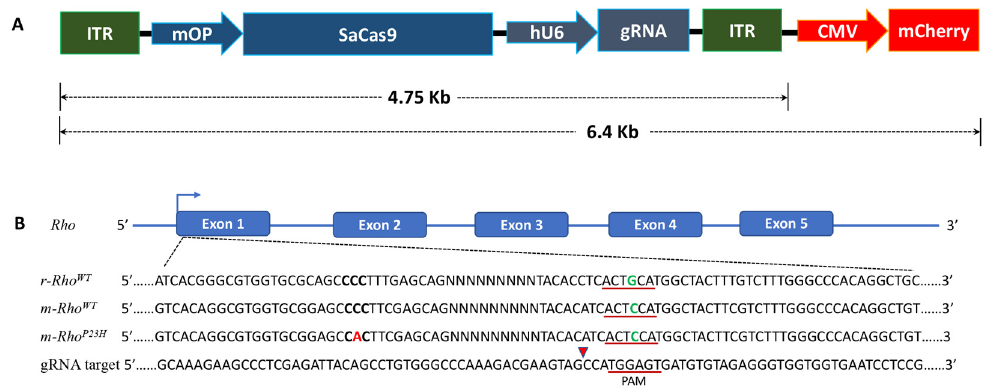
Figure 1. CRISPR/Cas9-mediated m- Rho P23H ablation in vivo. ( A ) Illustration of CRISPR vector; pAAV2-mOp-SaCas9-U6-gRNA-CMV-mCherry. ( B ) Rat and mouse wild-type (WT) Rho with exon 1 showing the P23H point mutation ( C → A ) in m- Rho (bold and red font). The gRNA targeting and PAM sequences are underlined. Mismatches in the PAM sequences are shown in green font. Red arrowhead indicates the predicted cleavage site in m-Rho P23H .